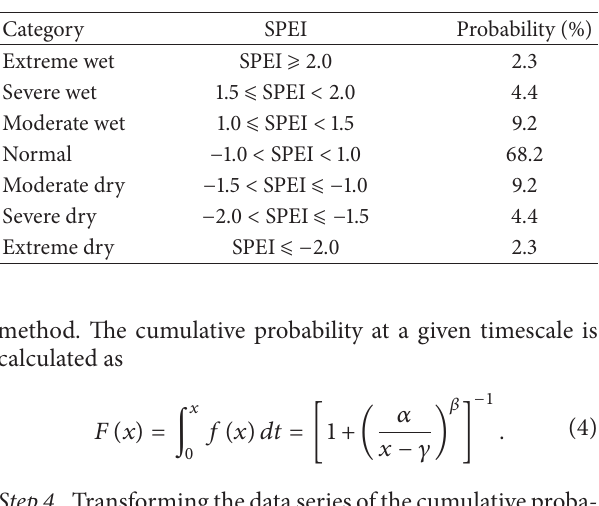
Table 1: SPEI classification and corresponding probabilities of